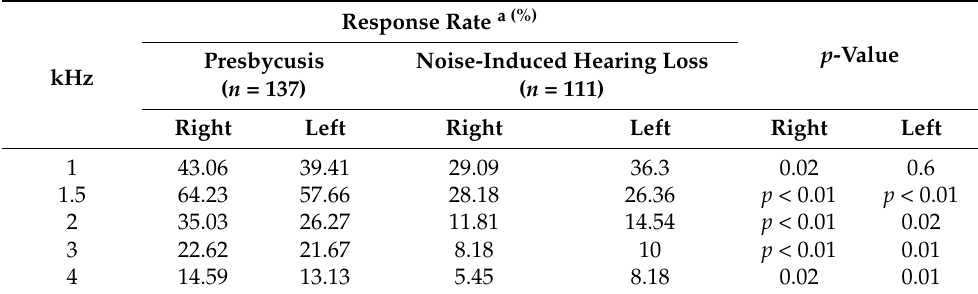
Table 6. DPOAE results showing response rates in each ear of tinnitus patients with presbycusis and noise-induced hearing